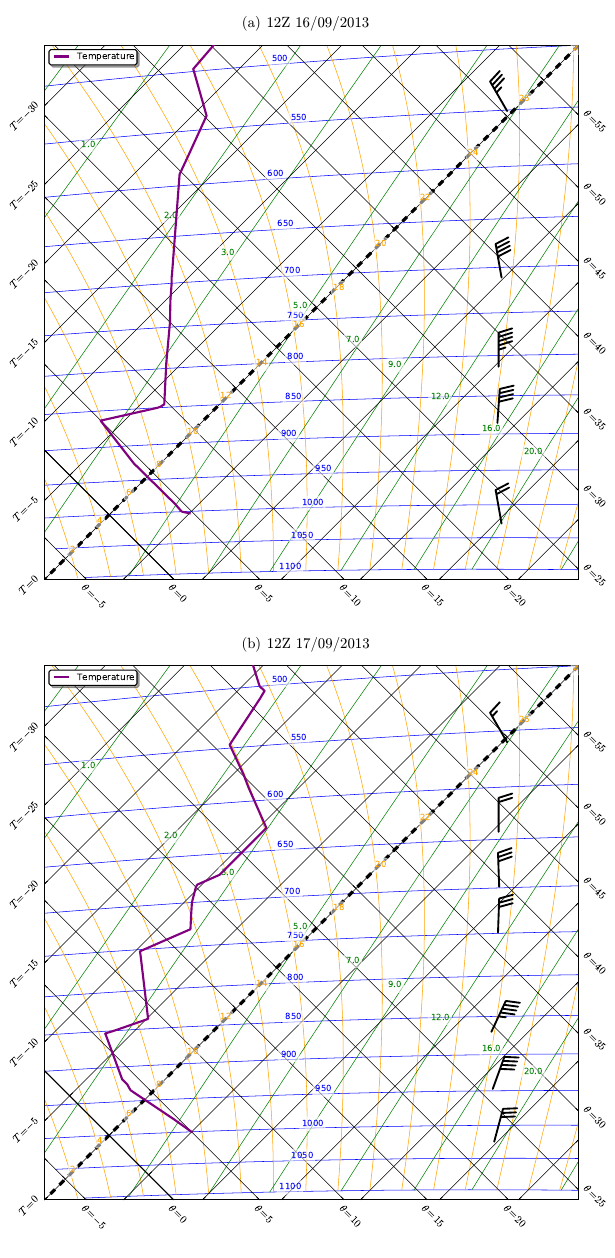
1 Figure 2. Radiosonde data retrieved from launches at Keflavík